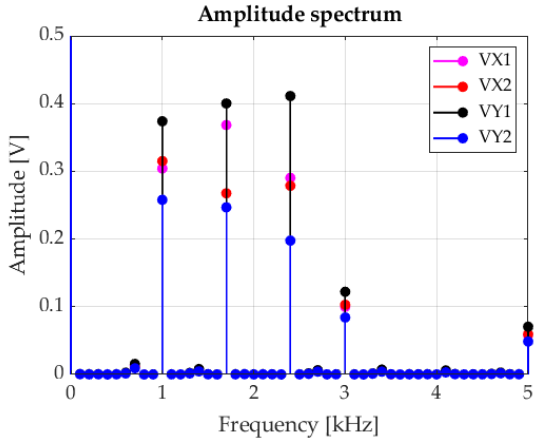
Figure 12. Amplitude spectrum.